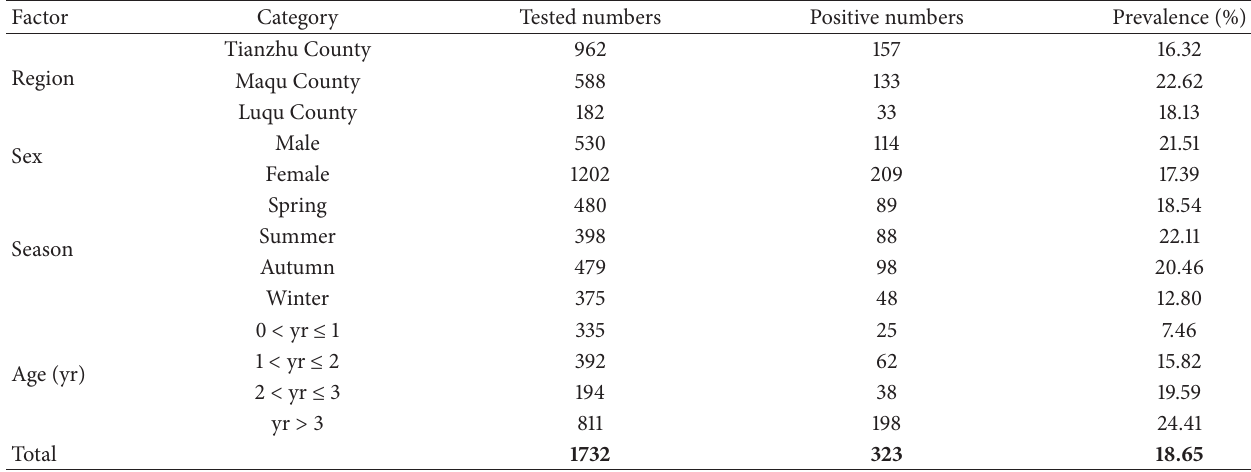
Table 1: Seroprevalence of Chlamydia abortus infection in Tibetan sheep associated with different factors in Gansu province, northwest China, by indirect hemagglutination assay (IHA).